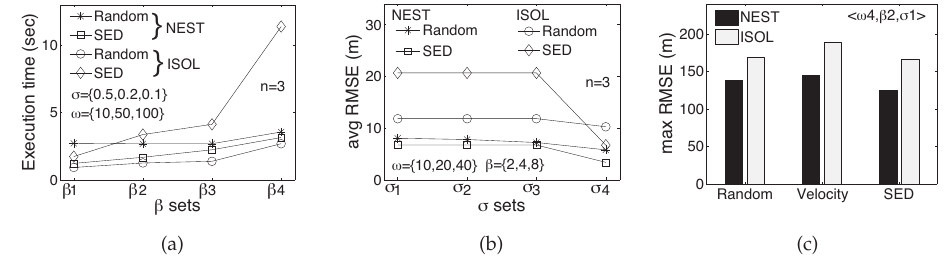
Figure 8: Nested vs. isolated maintenance of multi-level window